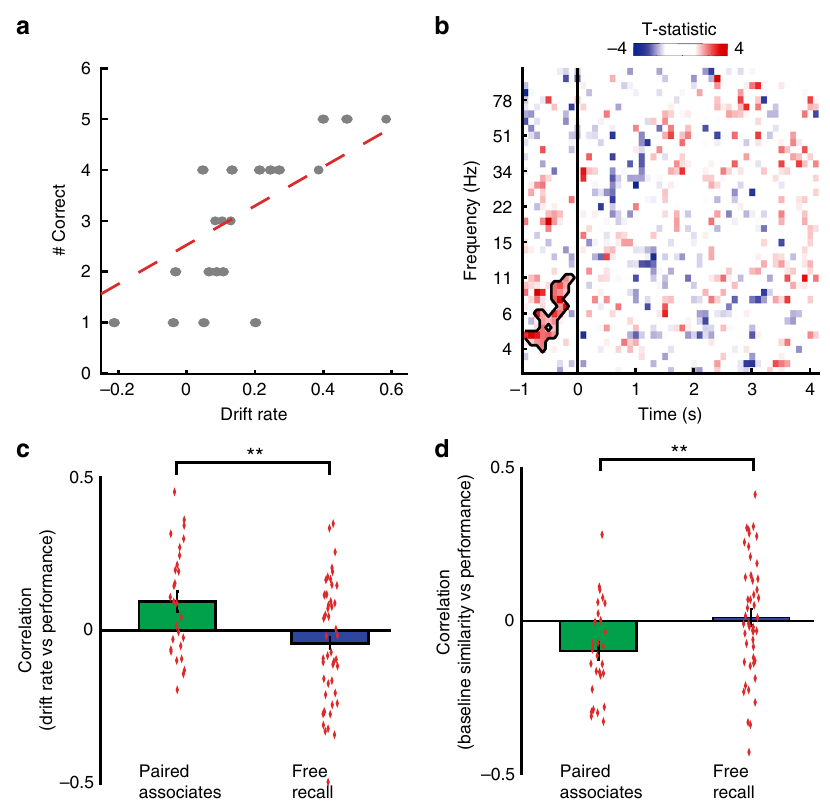
Fig. 2 Neural drift rate relates to memory performance. a Correlation between performance and rate of neural drift of interstimulus 3 – 12 Hz activity, across all lists of a single paired associates session in an exemplar participant. b Correlation between paired associates performance and drift rate is computed independently for each frequency and each time epoch during encoding. Across participants, the distribution of correlation coef fi cients is tested using a non-parametric clustering procedure. Mask identi fi es the time-frequency cluster exhibiting a signi fi cant relation between memory performance and drift rate ( p = 0.006). c Relationship between performance and rate of drift, as computed post-hoc using interstimulus, 3 – 12 Hz activity. Error bars represent SEM across 28 paired associates participants, and 48 free recall participants. * p < 0.05; ** p < 0.01, t -test. d Relationship between performance and baseline similarity, as computed using interstimulus, 3 – 12 Hz activity. Error bars represent SEM across 28 paired associates participants, and 48 free recall participants. * p < 0.05; ** p < 0.01, t